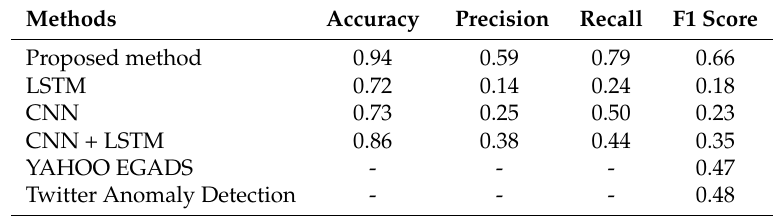
Table 3. Performance comparison of the proposed with other methods on class A1.